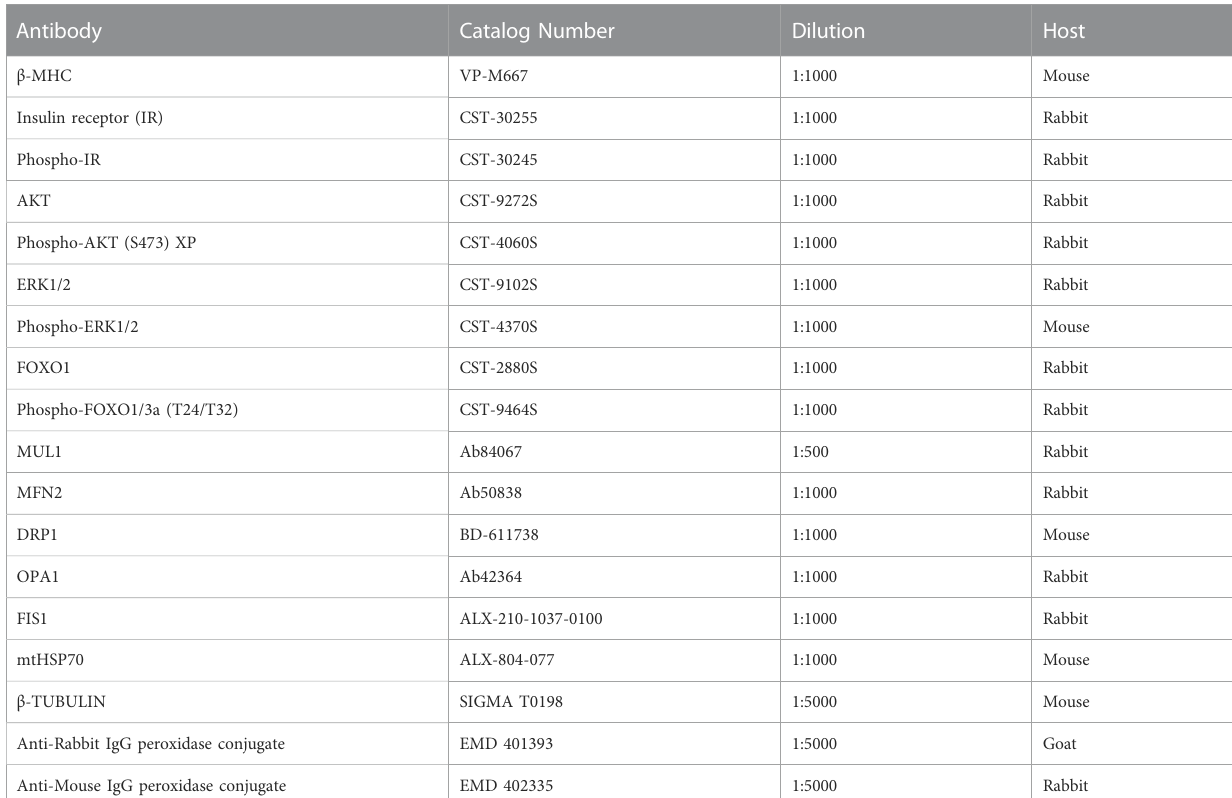
TABLE 1 List of antibodies used. Antibody Catalog Number